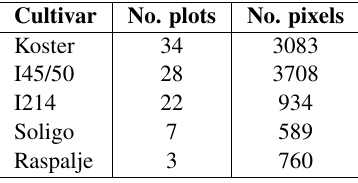
Table 2. Field data summary